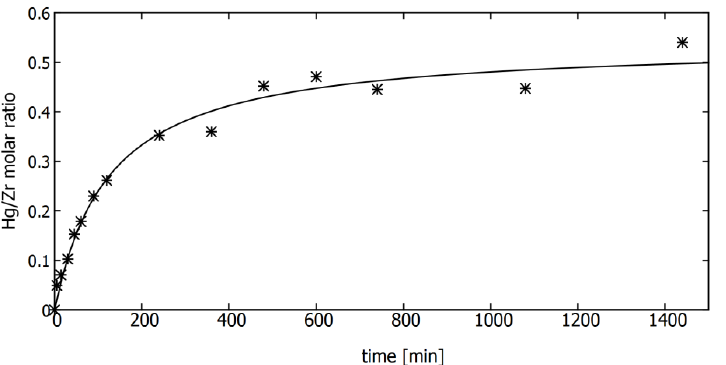
Figure 7. The kinetics of sorption on the UiO-66-type sorbent functionalised with mercaptoacetic acid and its approximation with the second-order kinetic model.